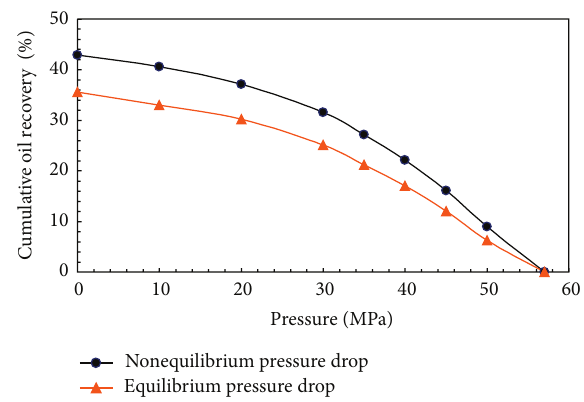
Figure 2: The condensate oil accumulation recovery in the equi- librium pressure drop and nonequilibrium pressure drop constant volume depletion experiment.